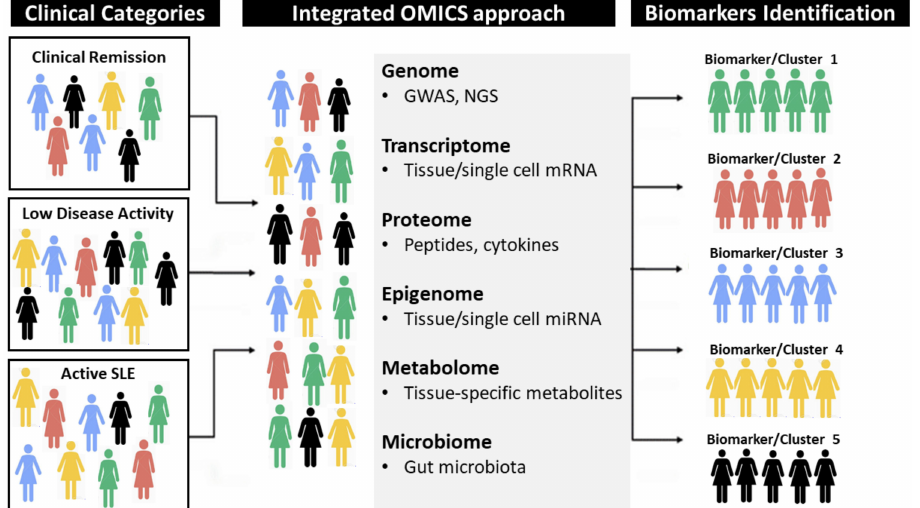
Figure 2. A hypothetical example illustrating how an integrated clinical and OMICS approach, driven by artificial intelligence, might help distinguishing homogeneous clusters from current heterogeneous phenotypes observed in Systemic Lupus Erythematosus (SLE). The example suggests that the way to identify new clusters with specific disease biomarkers should be tailored to the specific molecular events or pathways associated with disease activity and clinical phenotypes, providing a rationale for personalized therapeutic